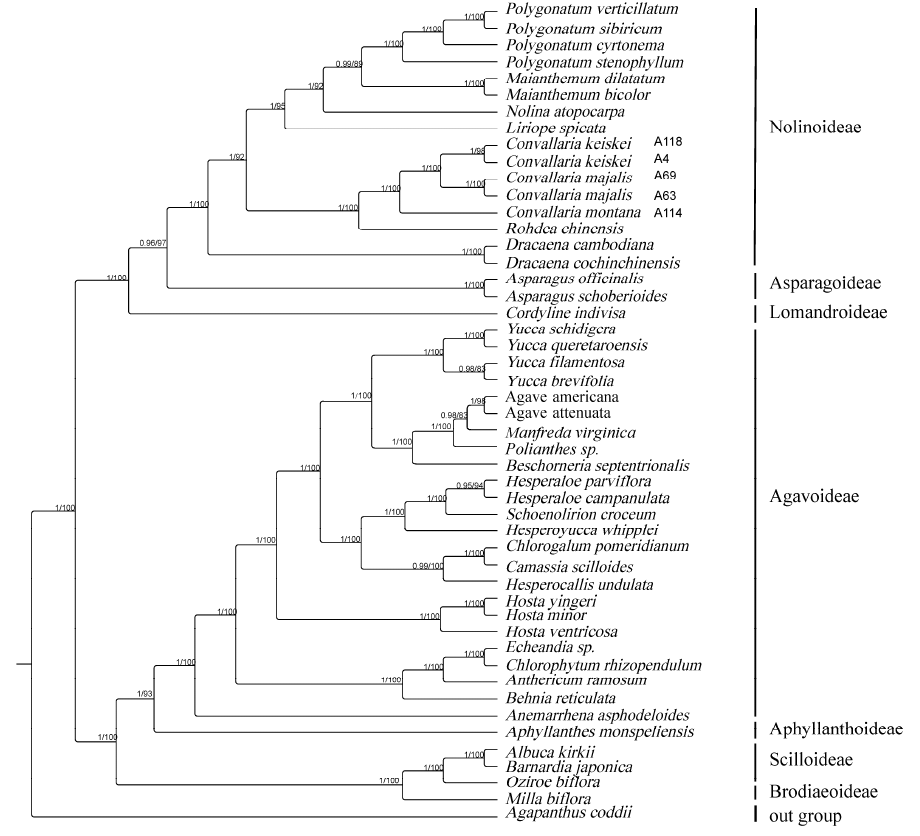
Figure 7. Phylogenetic relationships of Asparagaceae reconstructed using Bayesian inference (BI) and maximum likelihood (ML) based on 68 common CDS. Support values are indicated above the branches. PP, posterior probability; BS, bootstrap support.